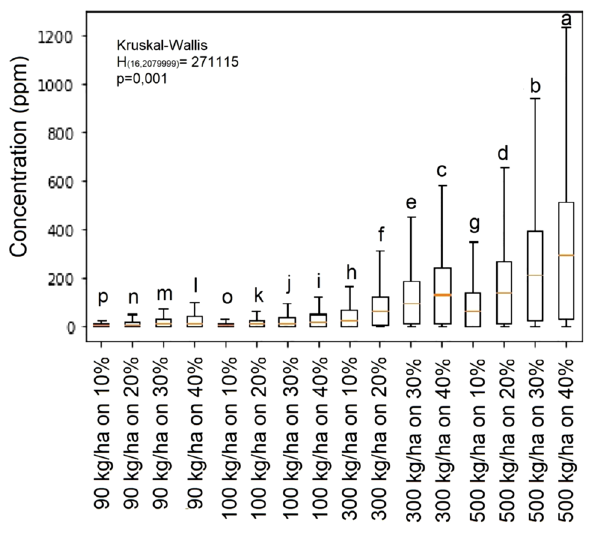
Fig. 10 N fixation in pastures in each of the treatments 2